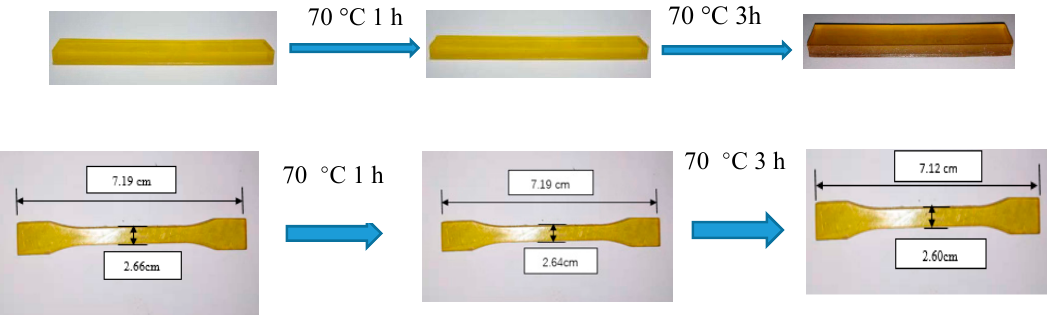
Table 3. Gel fractions of the samples with various heat treatment conditions. Sample